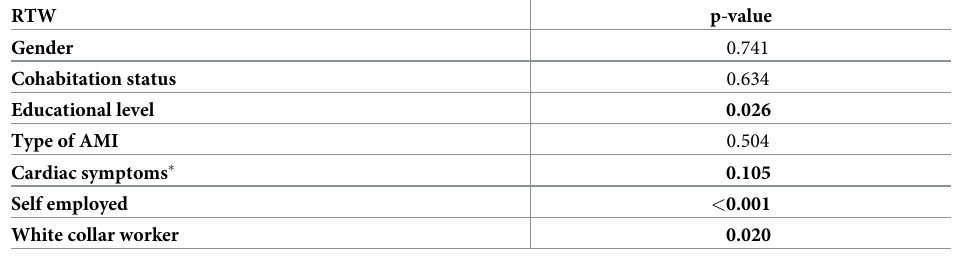
Table 3. Log-rank test of the association between timing of return to work status (RTW) and qualitative socio- demographic, clinical and occupational